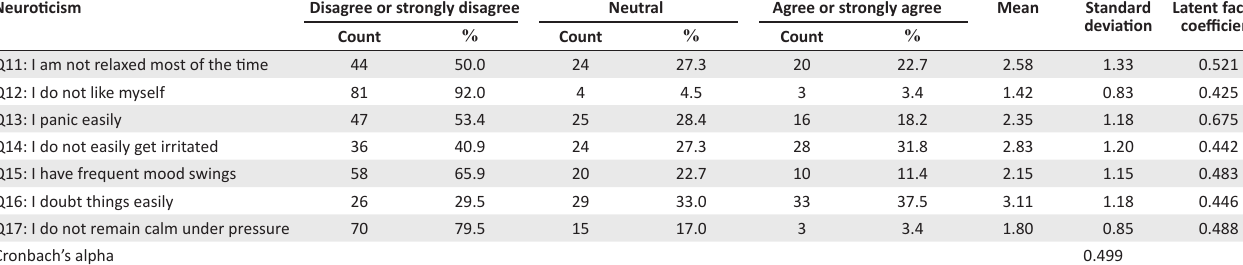
TABLE 3: Descriptive statistics for the construct of neuroticism. Neuroticism